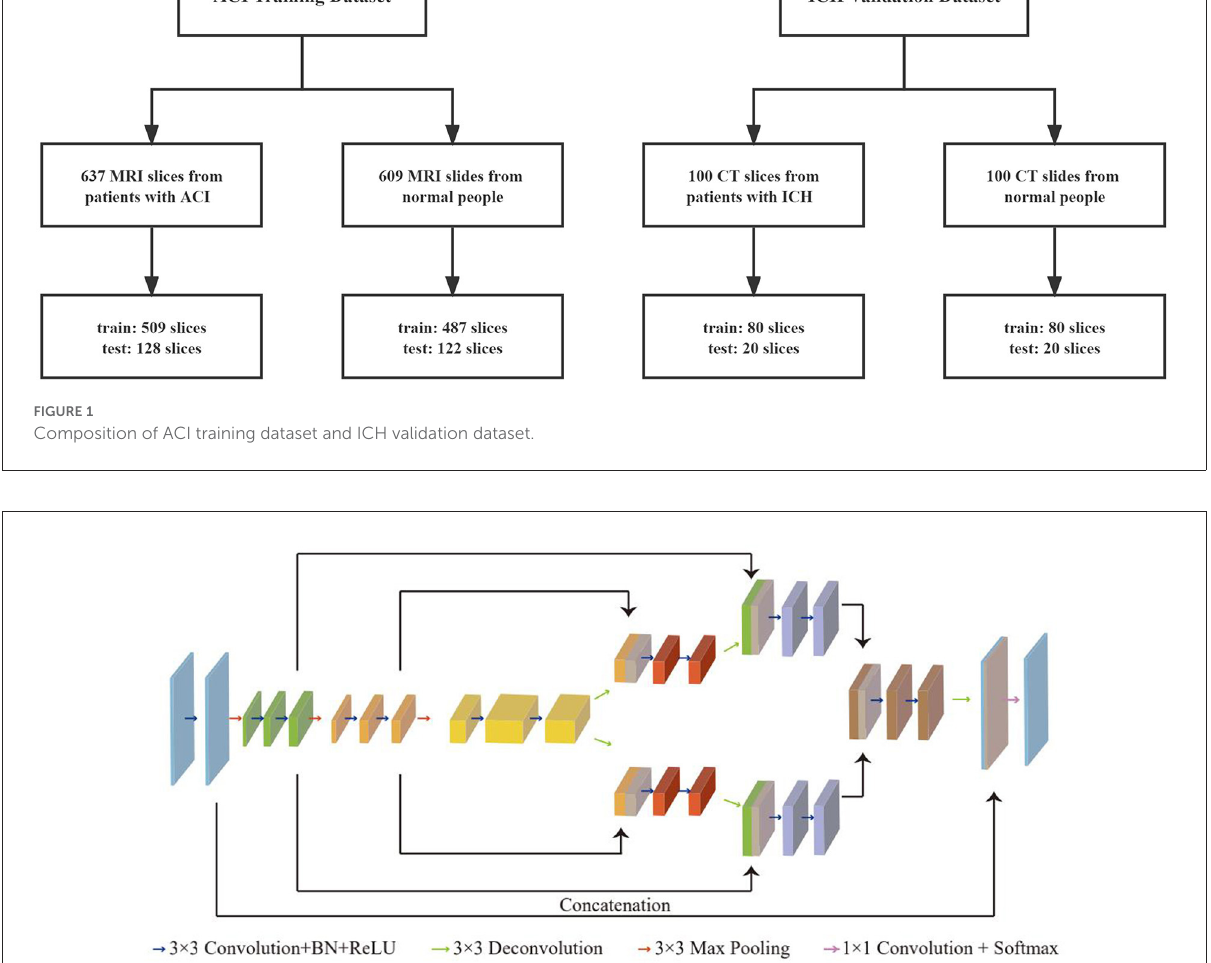
arrow represents a convolutional layer and every red arrow represents a max pooling layer, as shown in the figure.